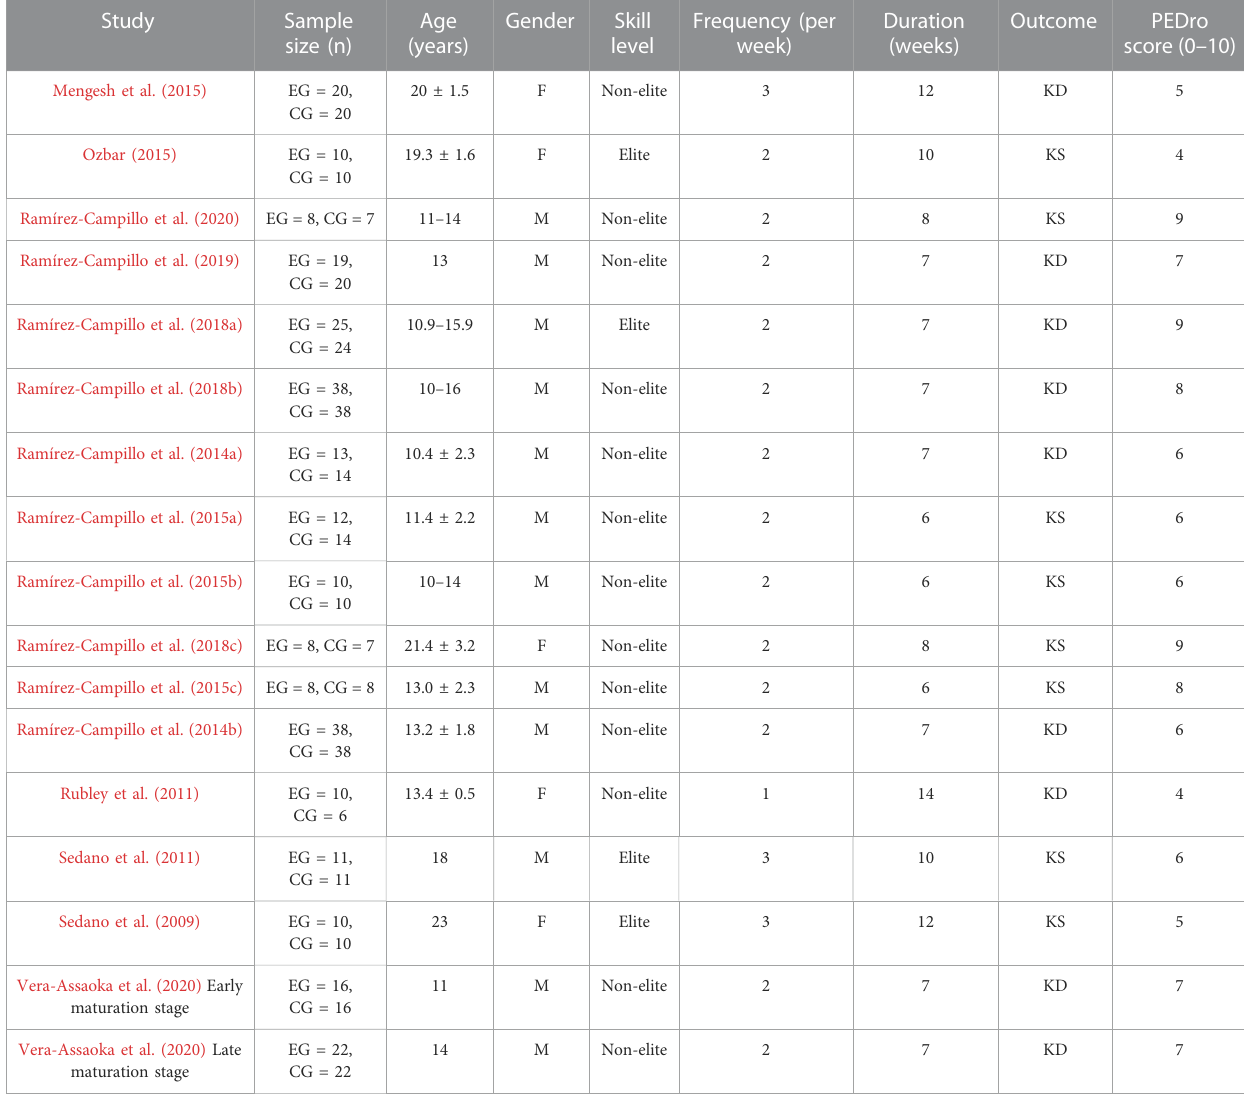
TABLE 1 Summary of characteristics of all studies meeting the inclusion